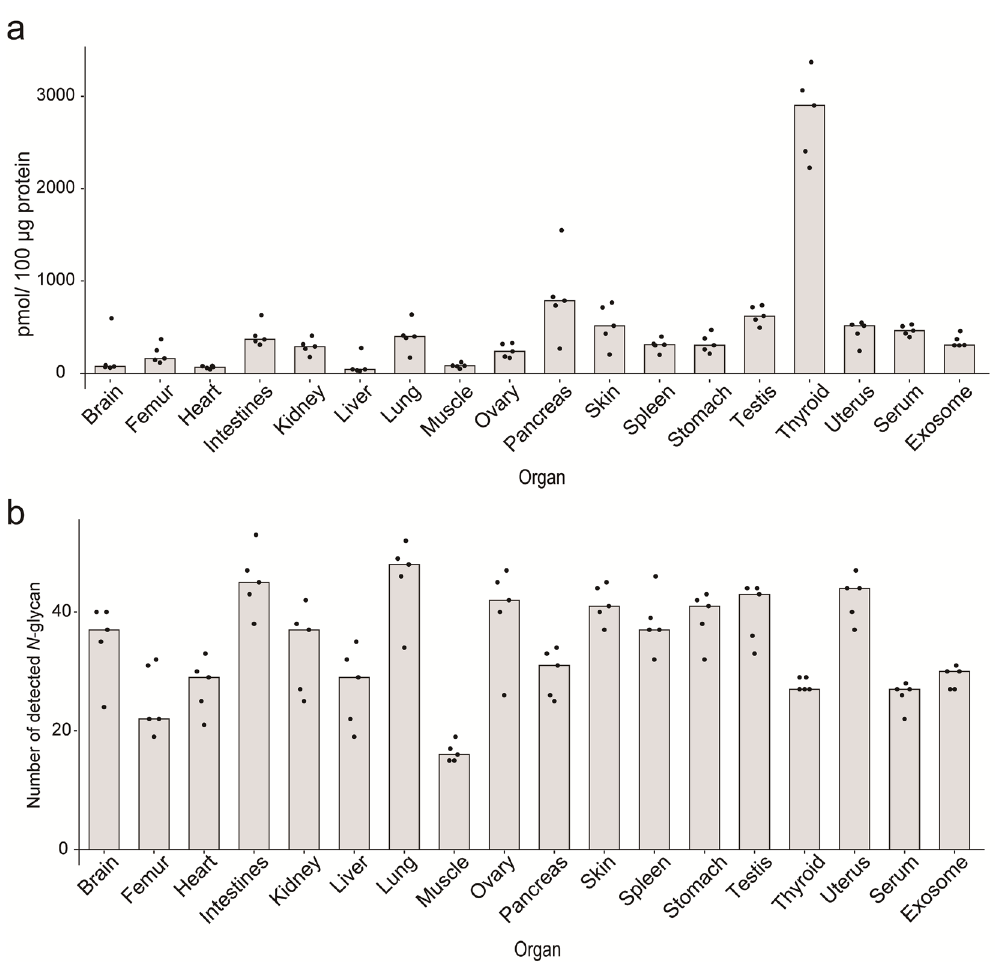
Figure 3. Posttranslational protein glycosylation is dependent strongly on the individual organs. ( a ) Differences in the expression levels of gross N -glycans represented as pmole/100 mg protein. ( b ) Total number of N -glycans (glycoforms) identified in the organs/tissues, serum, and exosomes, respectively. Column charts indicate the medians of the results for five independent